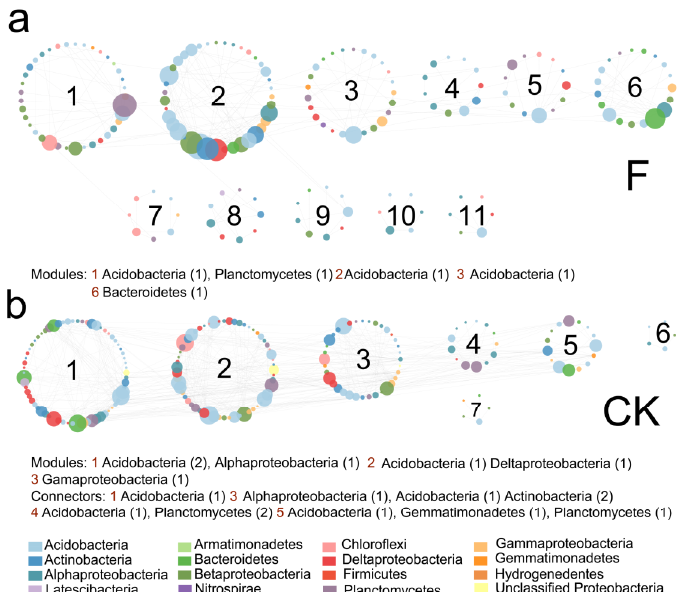
Figure 5. The structure of F ( a ) network and CK ( b ) network. CK = non-forested soils; F = forested soils. Modules with fewer than 5 members are not displayed. Circle colors represent the OTU node-affiliated taxa at the bacterial phylum level (Proteobacteria are at the class level) and the circle size represents the connectivity degree of the nodes. Grey lines represent positive correlations and red lines represent negative correlations. The numbers in the parentheses are the number of module hubs or connectors.